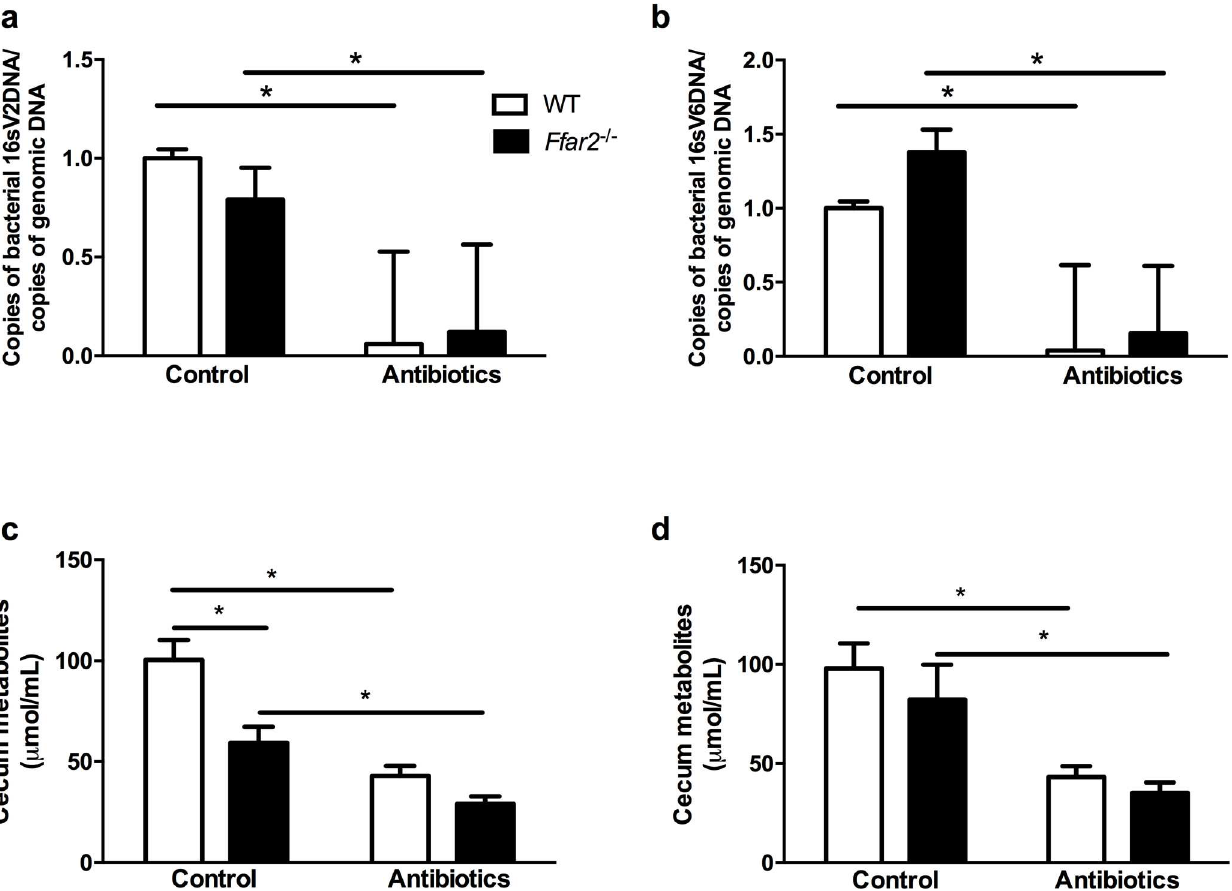
Fig 3. Antibiotic treatment significantly reduces cecum metabolites concentrations. Antibiotic treatment significantly reducedcecum bacterial populationsfor the V2 regions( a ) and V6 regions( b ) with both WT and Ffar2 -/- mice, where the copies of 16S V2 and V6 DNA copies (which reflects the amount of bacteria) was relative to the copies of mouse genomicDNA. Total metabolitelevels, which includesboth the SCFAs (acetate, propionate,and butyrate) and intermediates in SCFA synthesis (succinateand lactate) in cecum samplesare shown from Ffar2 -/- and WT mice before pregnancy( c ) and at G15 ( d ) under control and antibiotic-treated conditions. WT, white bars; Ffar2 -/- , black bars. Data are represented as mean ± SEM ( * p (cid:20) 0.05), n = 4–8 for a-b , n = 6–8 for c-d . Data (for a-d ) were comparedby Student’st-test. ( * , p < 0.05).